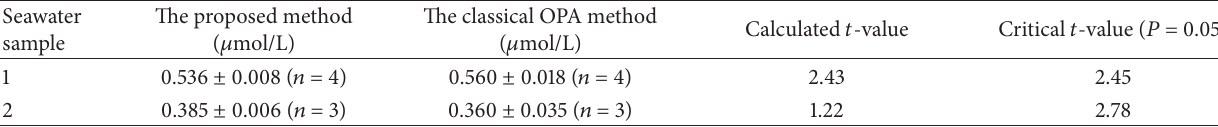
Table 5: Analytical results of the proposed method and classical OPA